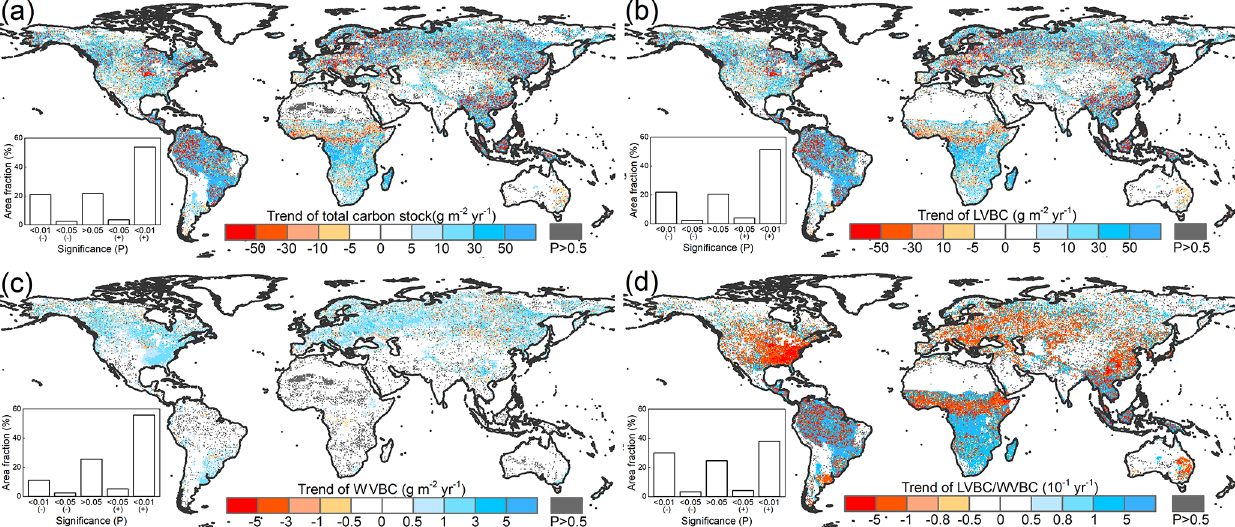
Figure 7. Spatial patterns in the trends of potential vegetation carbon stocks and their fractions from 1916 to 2015. Difference induced by changes in climate and CO 2 in terrestrial biomass carbon stock (a) , LVBC (b) , and WVBC (c) during the historic period 1916–2015. The blue bar indicates the significantly increasing trends, and the red bar indicates the significantly decreasing trends in carbon stocks. (d) Trend in the LVBC / WVBC ratio from 1916 to 2015. The blue bar indicates significantly increasing trends in the ratio, and vice versa. The grey bar indicates that the trend is statistically insignificant ( P > 0.05). The sub-graphs show the significant test results. A “ + ” symbol indicates a positive trend, and vice